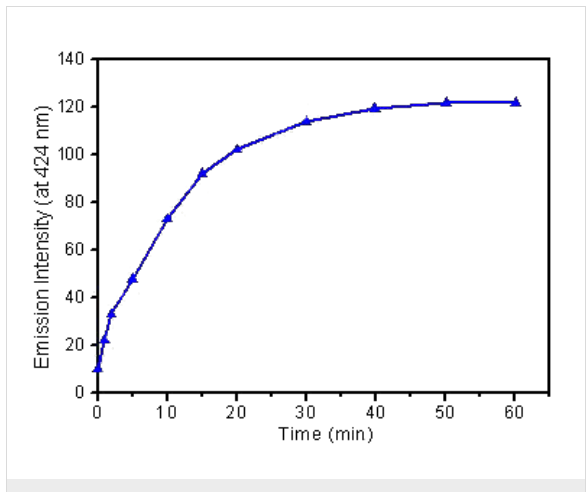
Figure 7: Time course plot of the change in emission intensity of acrithion 2